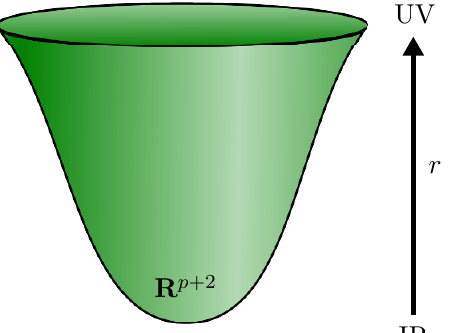
Figure 1 . The regular geometries interpolate between (cid:13)at Euclidean D p -branes in the UV and R p +2 in the